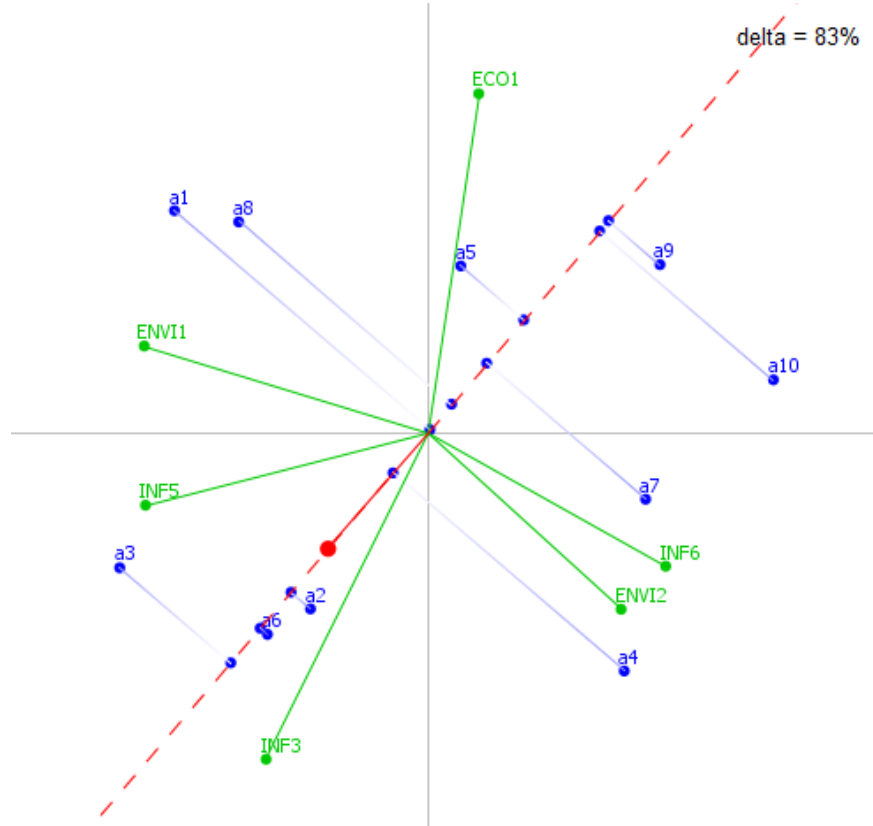
Figure 4. Visual representation of the problem on the GAIA